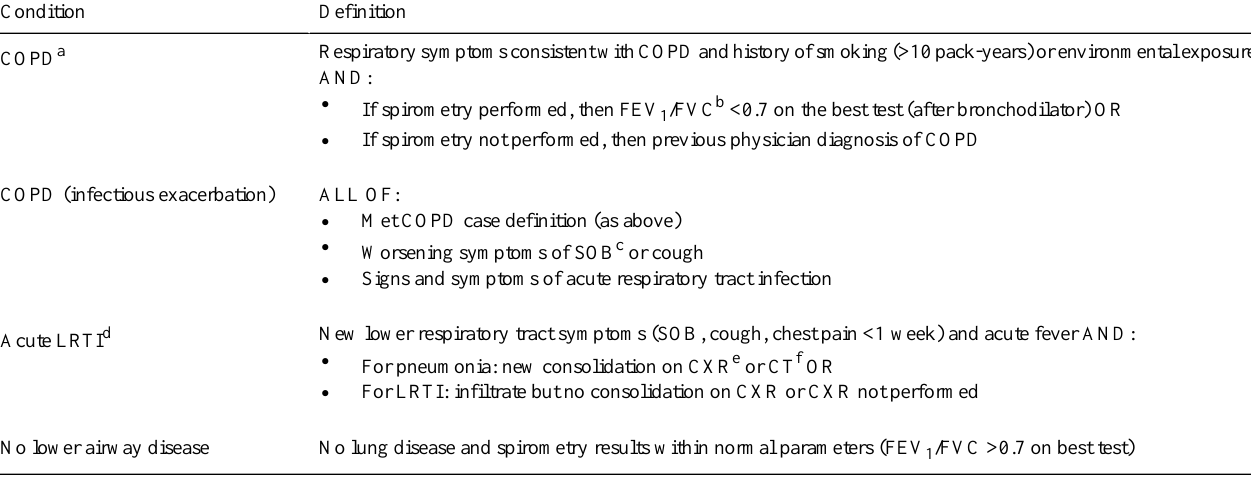
Table 1. Clinical diagnosis